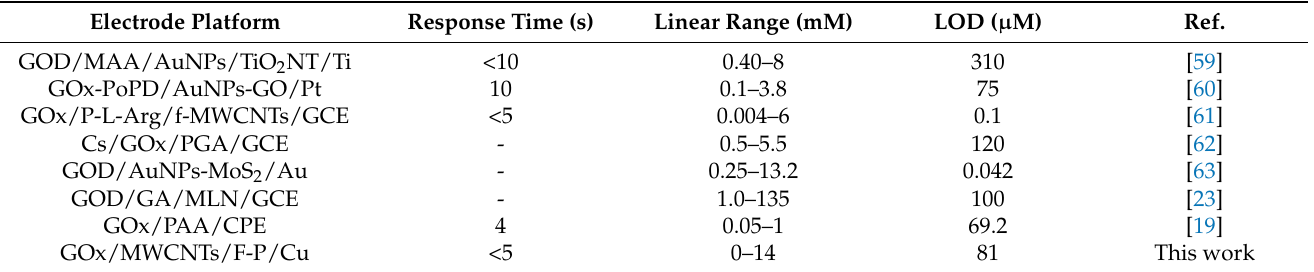
Table 1. Comparison of the analytical performance of some reported glucose biosensors. Electrode